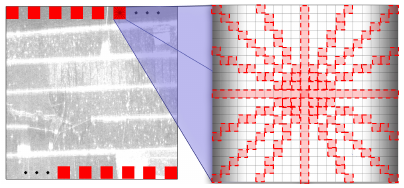
Figure 3: Scanning the image for reading the set f samples, wherein each sample is obtained k profiles roads (In the illus- tration, eight profiles).